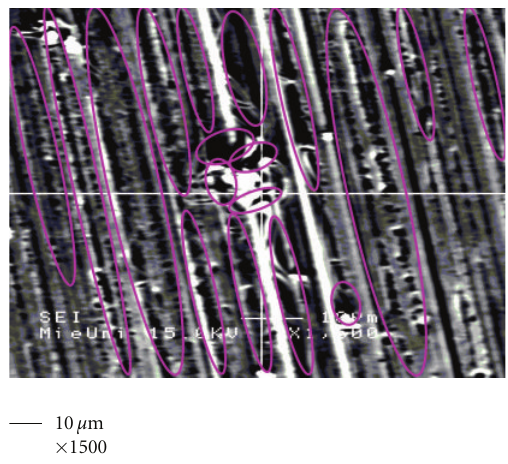
Figure 8: SEM image of Ag-doped TiO 2 film prepared under the condition of R = 50